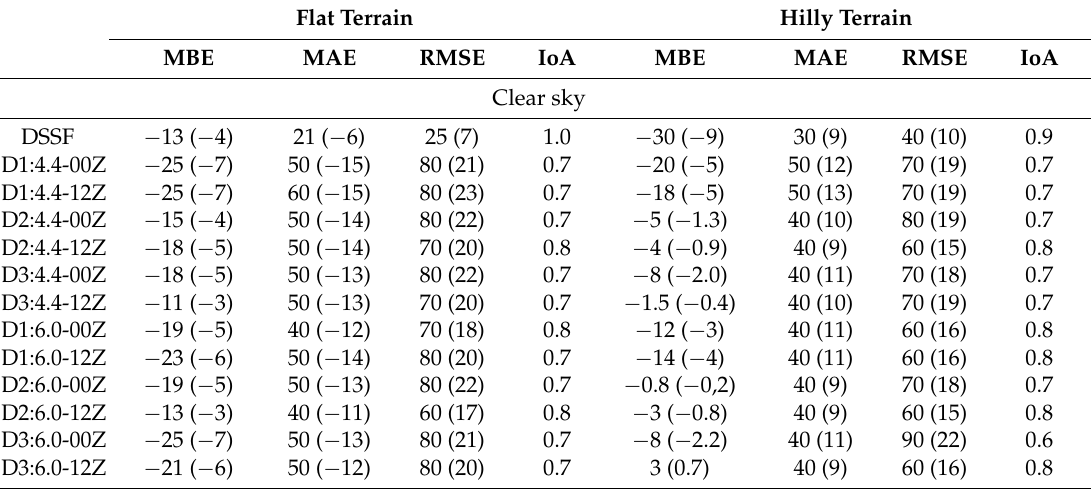
Table 3. Daily solar radiation error and accuracy statistics, depending on flat or hilly terrain and clear or cloudy conditions, during the winter 2010–2011. MBE, MAE and RMSE in W ¨ m ´ 2 . Relative errors (%) rMBE, rMAE and rRMSE in brackets at the